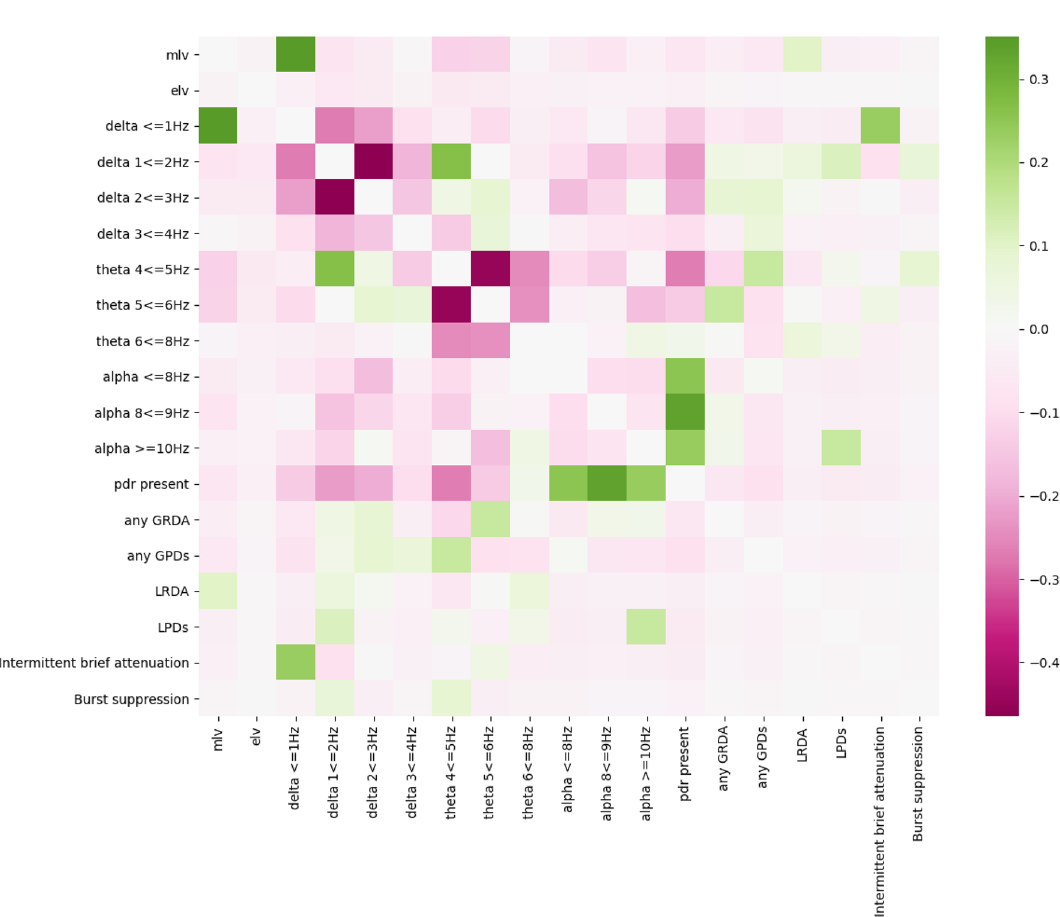
Figure 5. Spearman’s correlations between all EEG features in the model. A heatmap showing Spearman’s correlations between all input features of the VE-ICANS model ( green , positive correlation vs. pink , negative correlation). Features with positive correlation were often present in the same